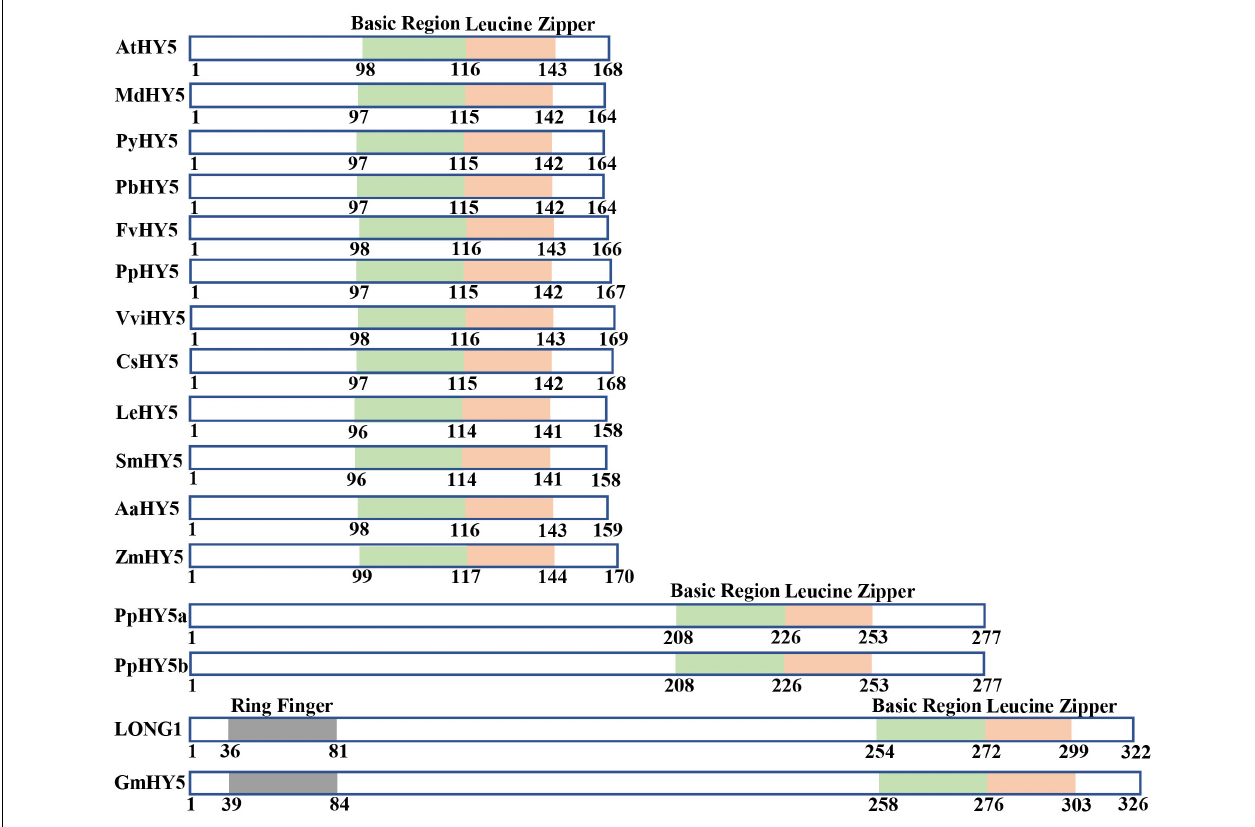
FIGURE 1 | HY5 orthologs are evolutionally conserved in protein structure. Schematic representations of domains present in multiple HY5 orthologs. AtHY5 (Oyama et al., 1997), MdHY5 (An et al., 2017a), PyHY5 (Wang et al., 2020), PbHY5 (Wu et al., 2019), FvHY5 (Li Y. et al., 2020), PpHY5 (Zhao et al., 2017), VviHY5 (Loyola et al., 2016), CsHY5 (Huang et al., 2019), LeHY5 (Liu et al., 2004), SmHY5 (Jiang et al., 2016), AaHY5 (Hao et al., 2019), ZmHY5 (Huai et al., 2020), PpHY5a and PpHY5b (Yamawaki et al., 2011), LONG 1 (Weller et al., 2009), and GmHY5 (Song et al., 2008). Numbers indicate the position of amino acid